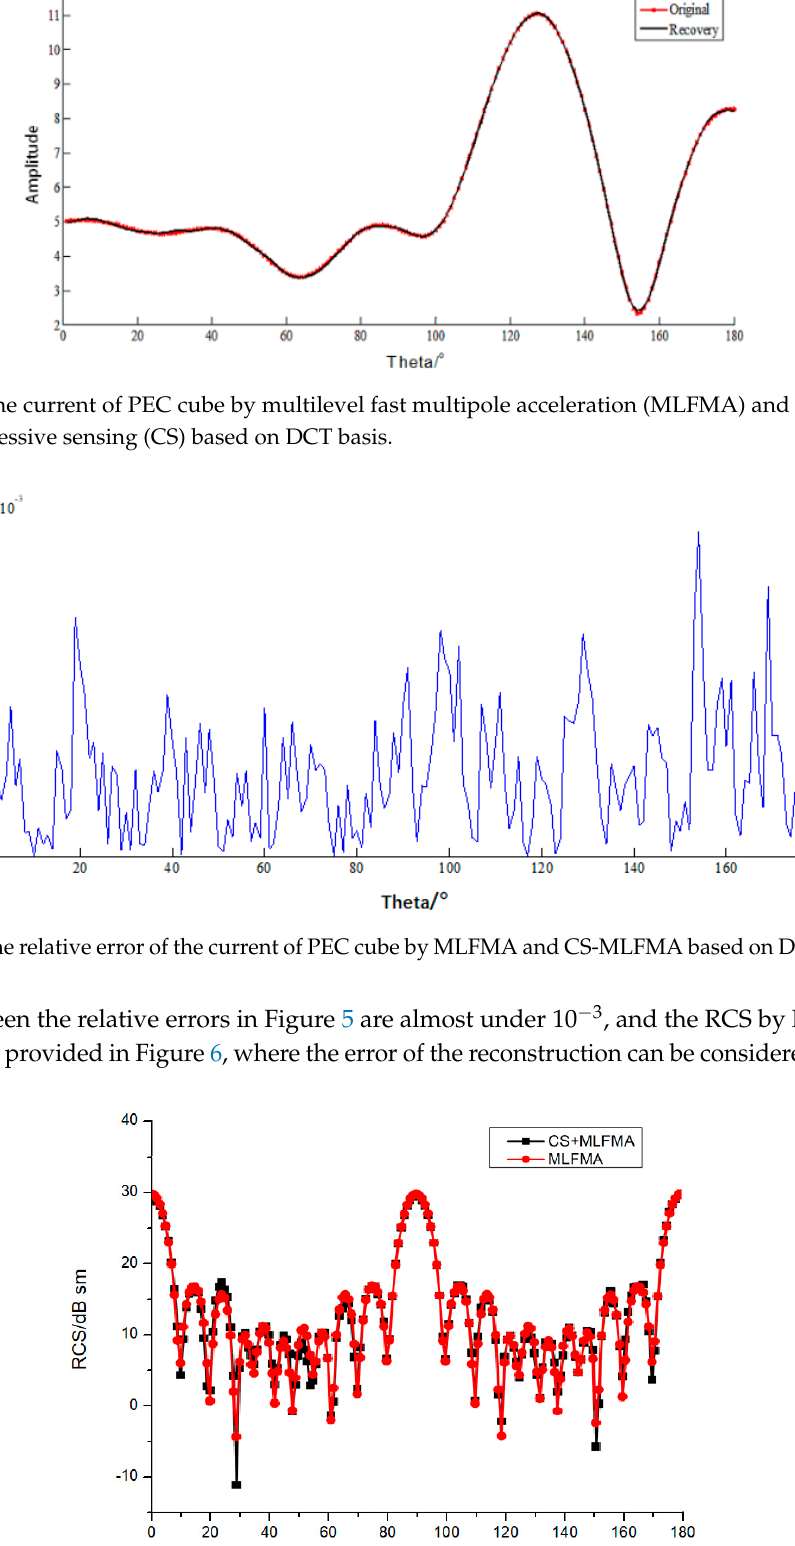
Figure 3. The projection value of the original current of PEC cube based on DCT basis.